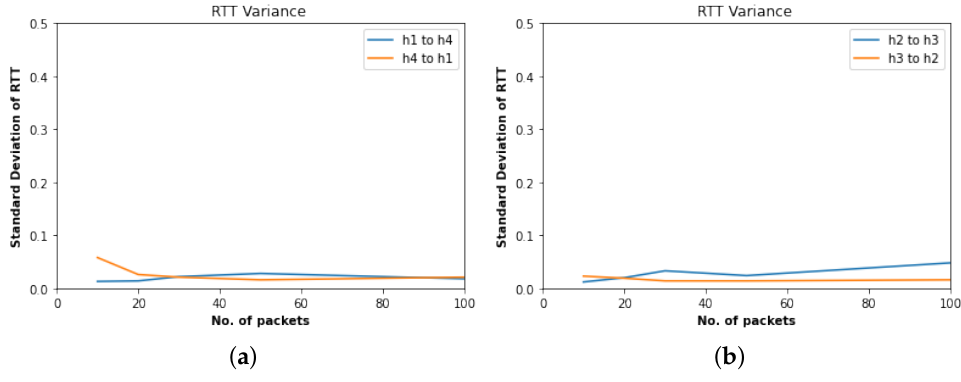
Figure 14. RTT variance for neighbouring AS of SDN, ( a ) h1 <-> h4 and ( b ) h2 <->